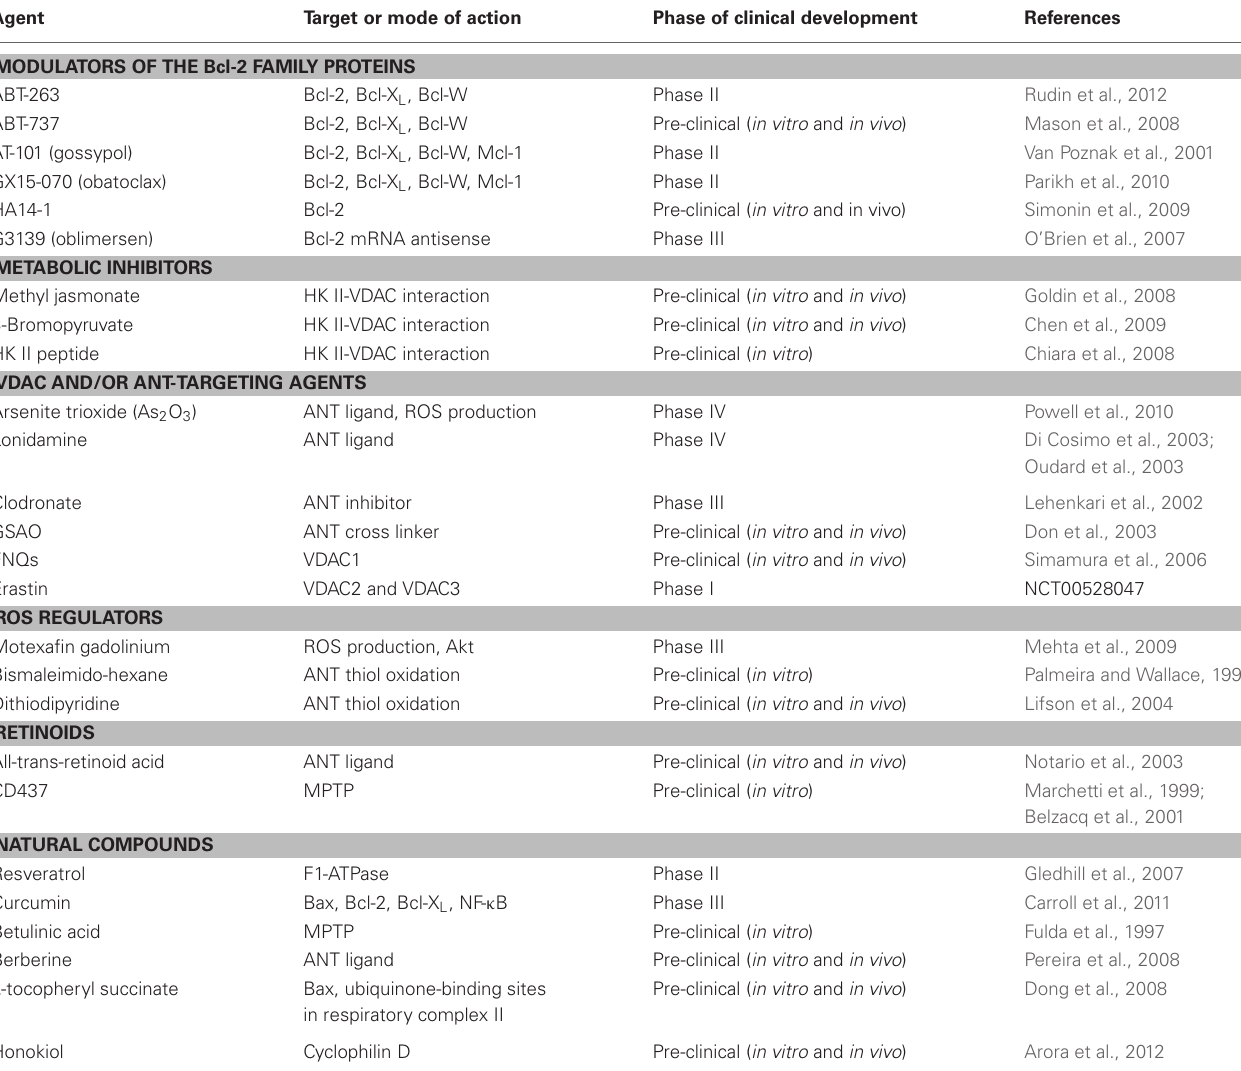
Table 1 | Summary of the developmental status of anti-cancer agents targeting mitochondrial apoptotic